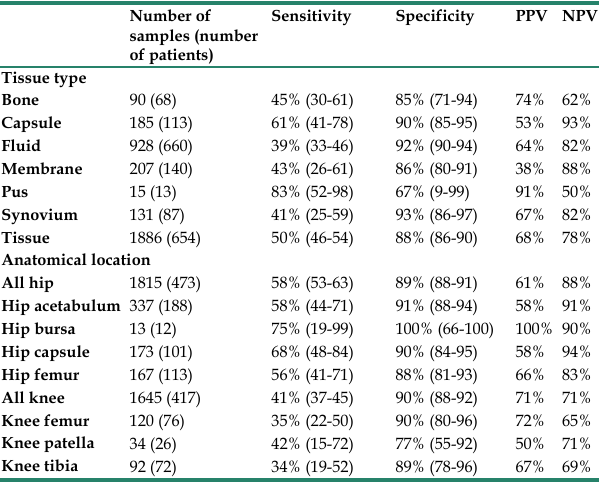
improved false positive rates without compromising the true positive rates. Table 4: Diagnostic accuracy divided by tissue type and anatomical location Number of Sensitivity Specificity PPV samples (number of patients)